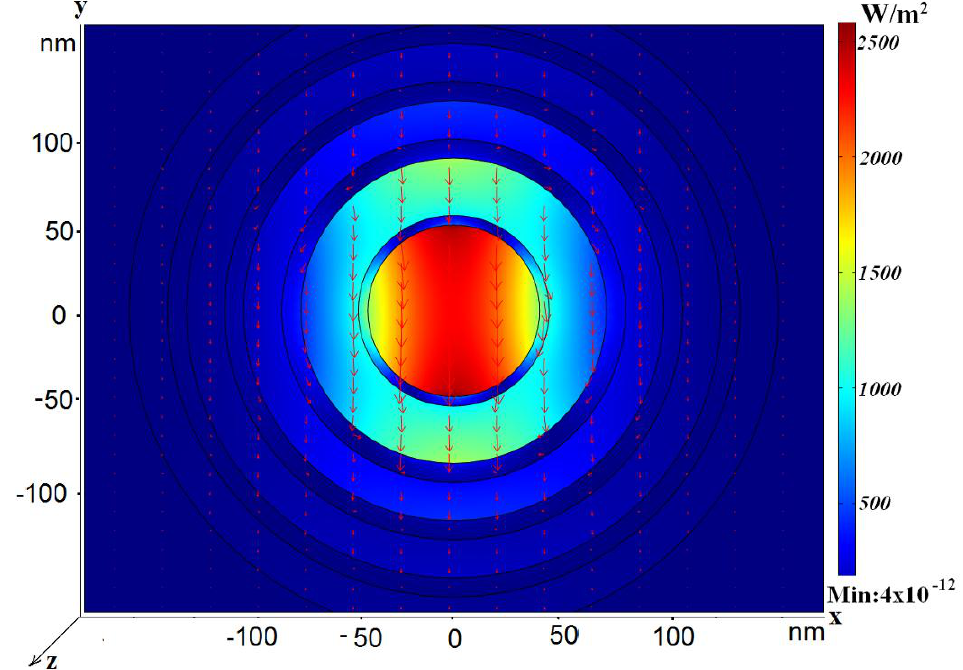
Figure 4. Power flow distribution for the dipole-like mode in case r = 45 nm; h = 5 nm; in silver1 h = 30 nm; h = 10 nm; h = 20 nm; R   ; L = 1.67  m, glassr1 silver2,3,4 glass2,3,4 out n = 1.010 + i 0.0245. The electric field vector is shown by eff